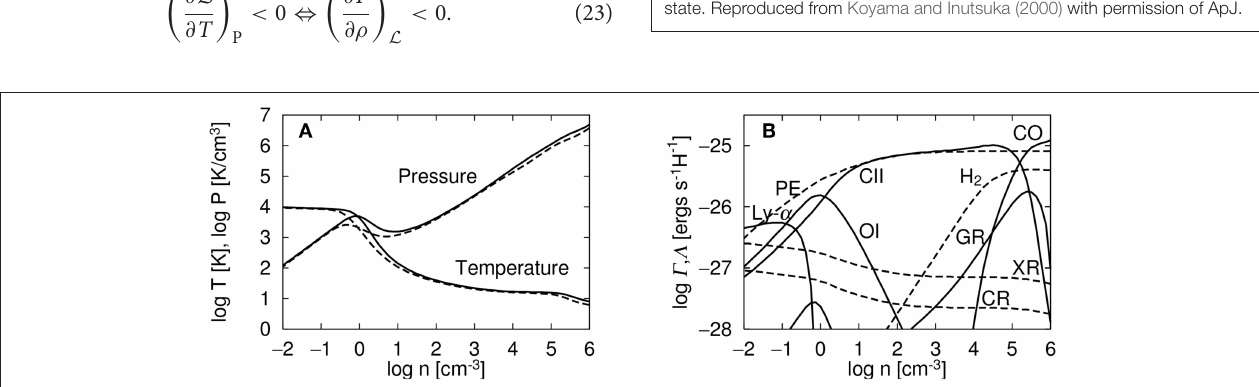
FIGURE 1 | A phase diagram of ISM and important heating and cooling processes shown in Koyama and Inutsuka (2000). (A) Equilibrium temperature and pressure with absorbing column density of 10 19 cm − 2 (solid lines), 10 20 cm − 2 (dashed lines). (B) Heating (dashed lines) and cooling rates (solid lines) for unshielded gas per hydrogen nucleus at equilibrium. Heating processes are, photoelectric effect from small grains and PAHs (PE), X-ray (XR), Cosmic-ray (CR), and H 2 formation/destruction. Cooling processes are CII fine-structure (CII), OI fine-structure (OI), Hydrogen Lyman- α (Ly- α ), CO rotation/vibration line (CO), and atomic and molecular collisions with dust grains (GR). Reproduced from Koyama and Inutsuka (2000) with permission of ApJ.